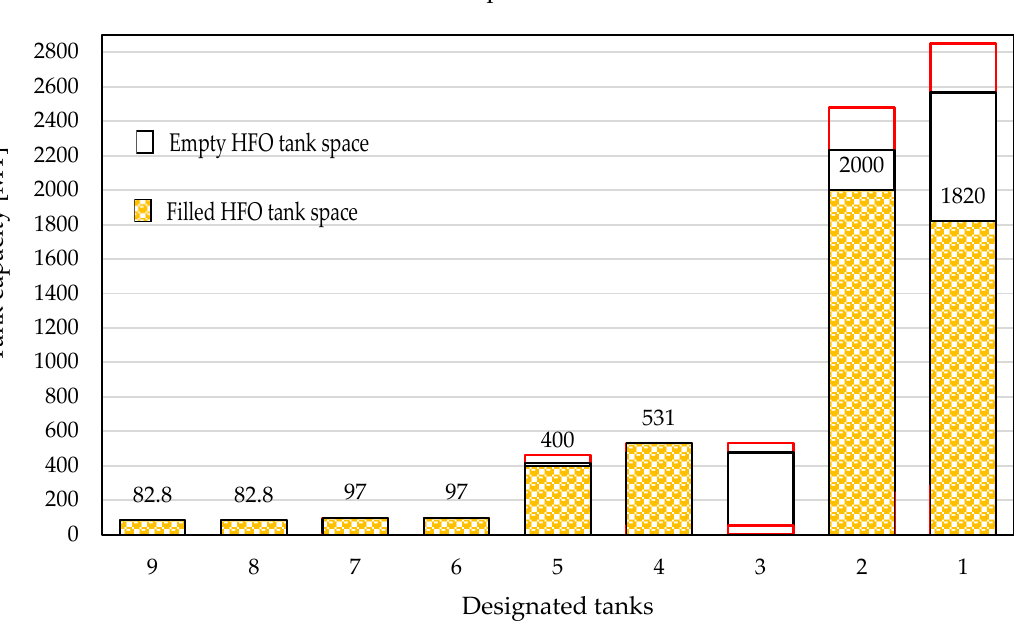
Figure 7. HFO bunker condition before bunker distribution for the third example.